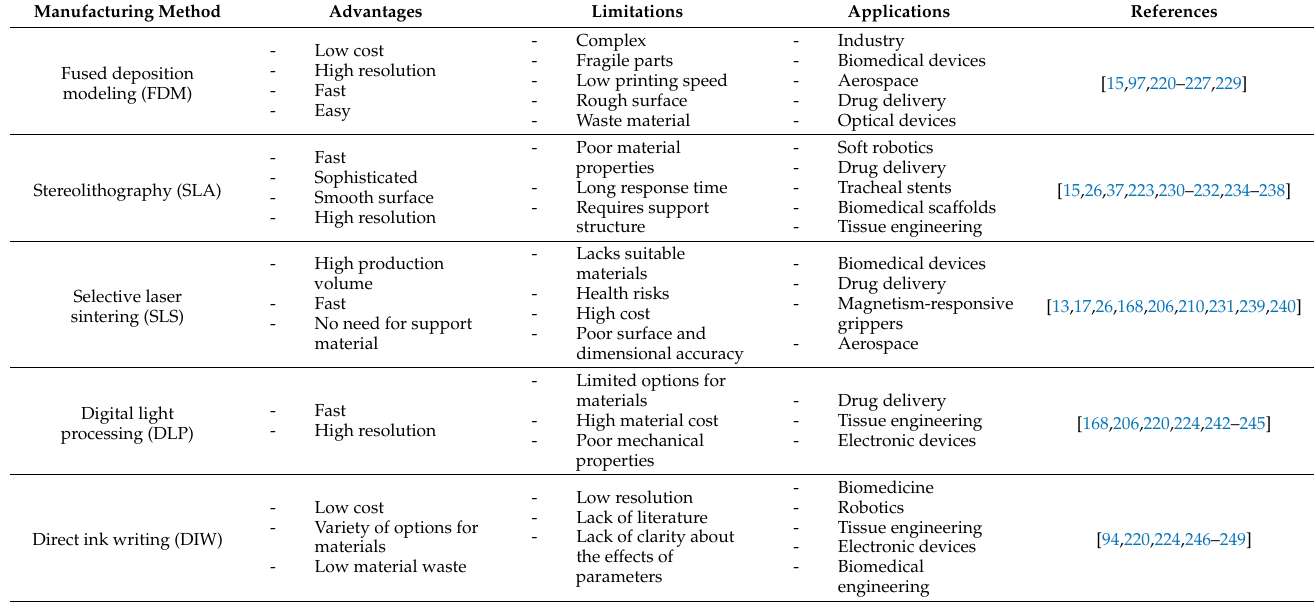
Table 5. Summary of Materials Used in 4D Printing